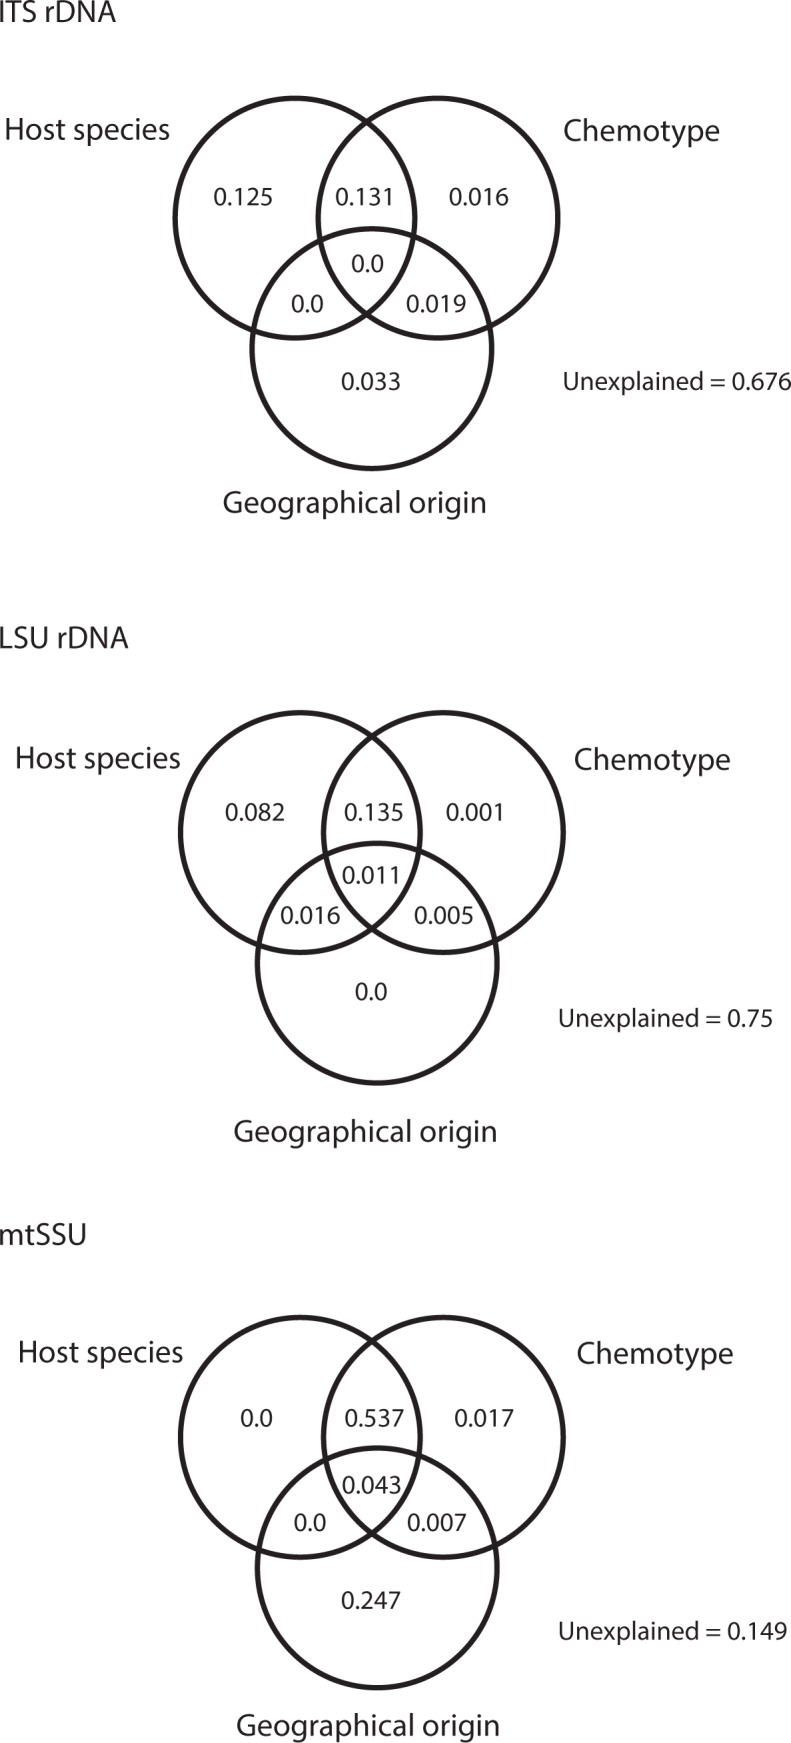
Diagrams show the results of redundancy analyses of Heterocephalacria bachmannii.Fractions of genetic variance explained by host species, chemotype of the host and geographical origin.